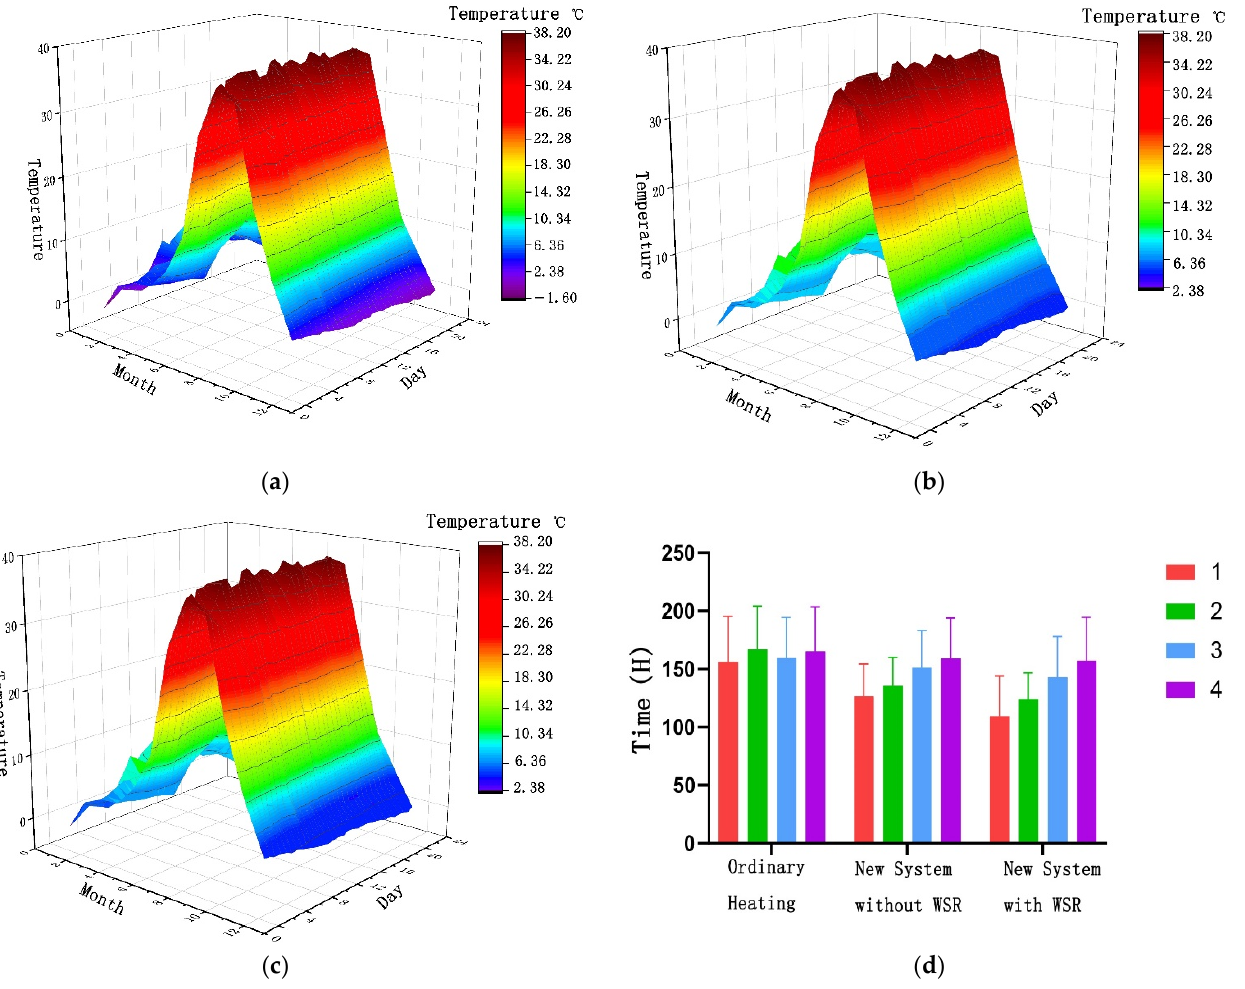
Figure 16. ( a ) Thermal comfort time under ordinary heating. ( b ) Thermal comfort time under the new system (with WSR). ( c ) Thermal comfort time under the new system (without WSR). ( d ) Thermal comfort time of the